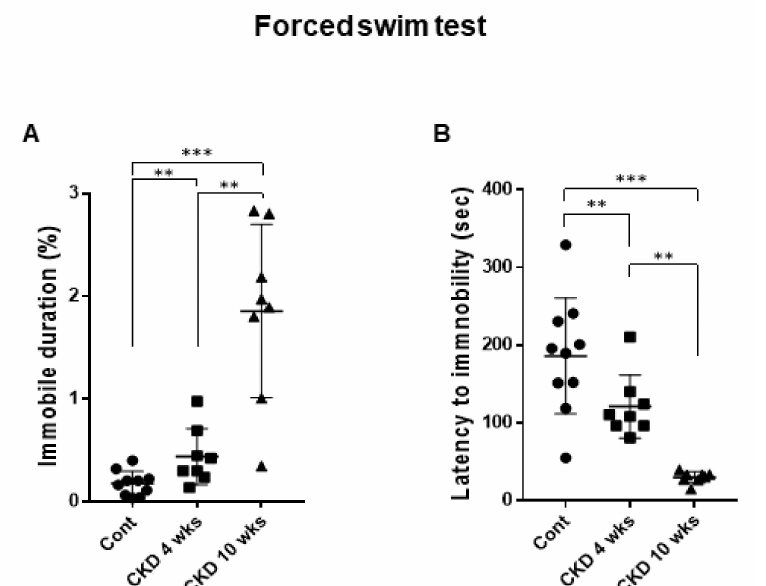
Figure 4. Depression-like behaviors in CKD and wild-type rats. Increased percentages of immobility during forced swim test in CKD rats ( A ). Decreased latency to immobility of forced swim test in CKD rats ( B ). Data are presented as means ± standard errors of the mean. ** p < 0.01, *** p < 0.001, one-way analysis of